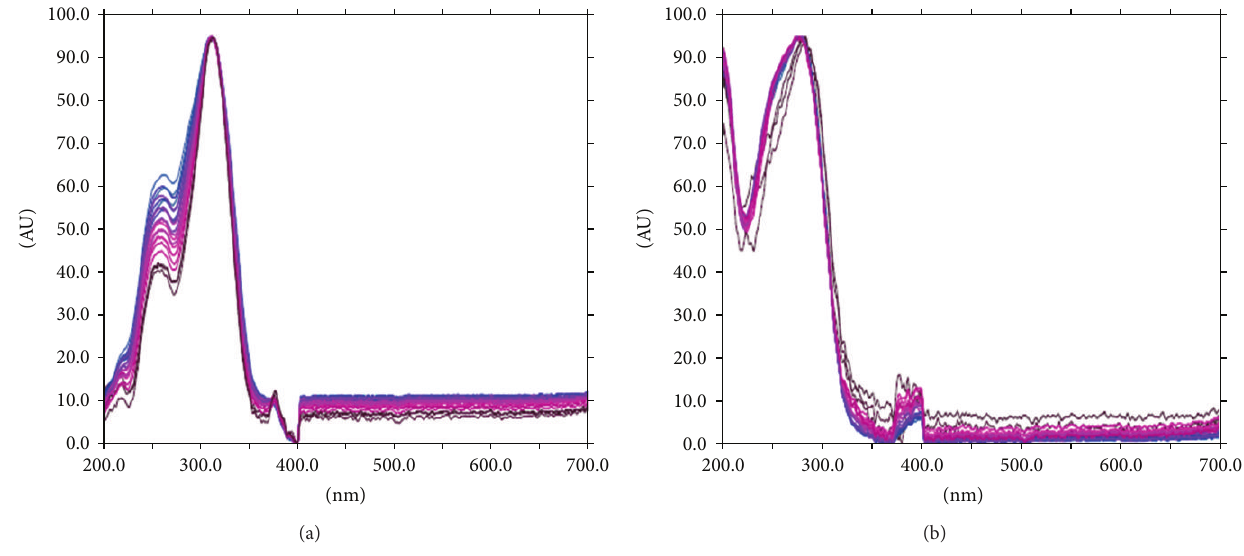
Figure 6: Peak purity spectra of (a) Telmisartan and (b) Atorvastatin.